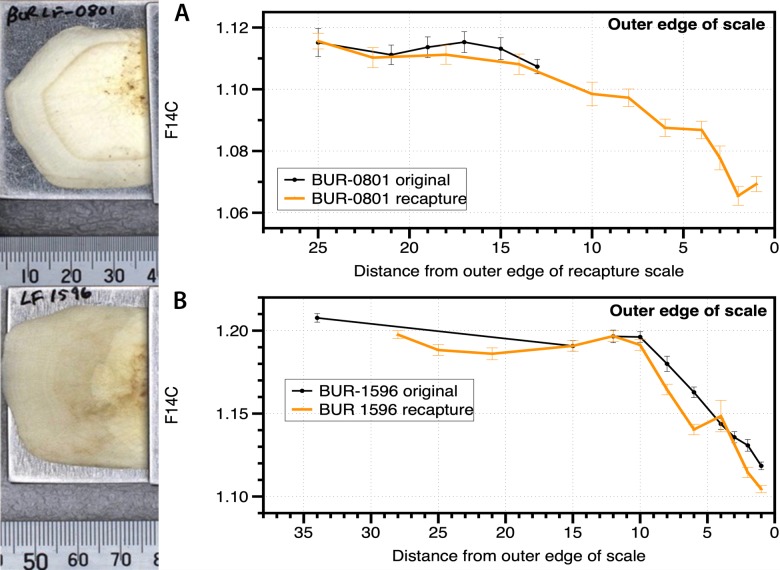
Oxytetracycline stained fish scales and F14C.A) Original fish 745 mm long, on recapture fish 1010 mm long, OTC mark visible on scale. B) Original fish 1036 mm long, on recapture fish 1060mm long, OTC mark not visible on scale.